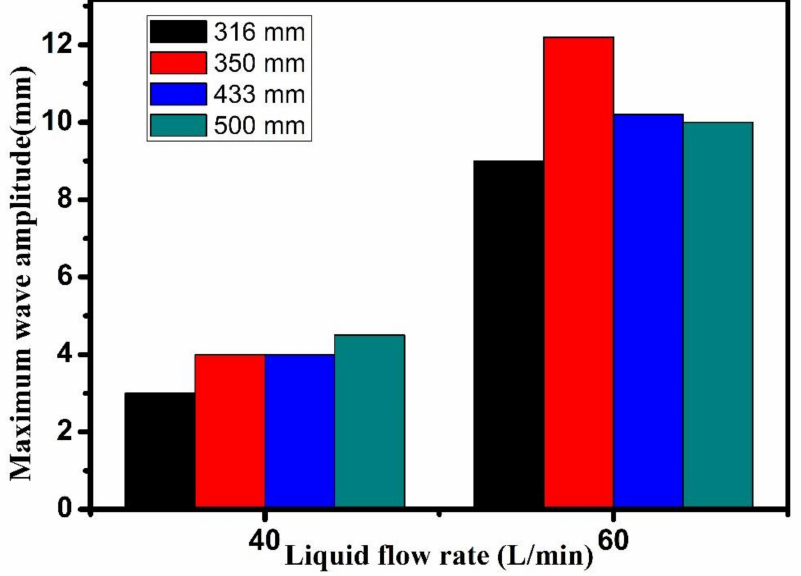
Figure 7. Effect of section size (mould width) on maximum surface wave amplitude for 0 ◦ port under different operating conditions.